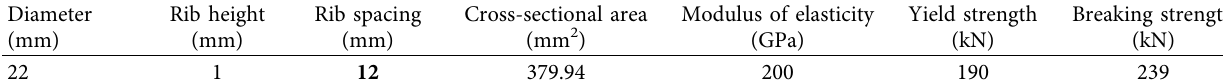
Table 1: Structure and mechanical parameters of the MSGLW-500 bolt.